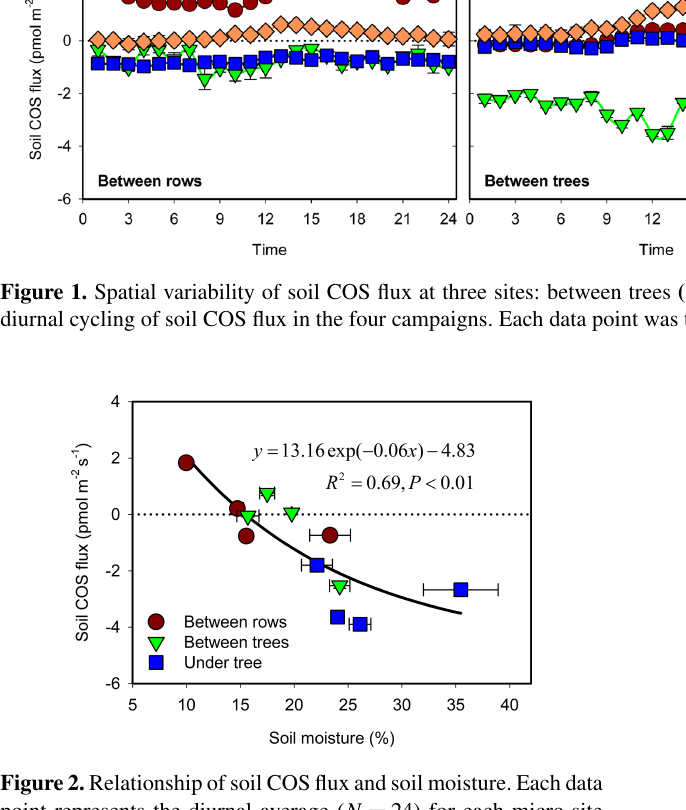
Figure 3. Soil COS flux as a function of temperature and its linear regression line. Each data point represents the diurnal average ( N = 24) for each site and season (campaign). Error bars ± 1 SE around the mean. The data points marked by black circle were collected during irrigation cycle (enhanced uptake) and were excluded from the